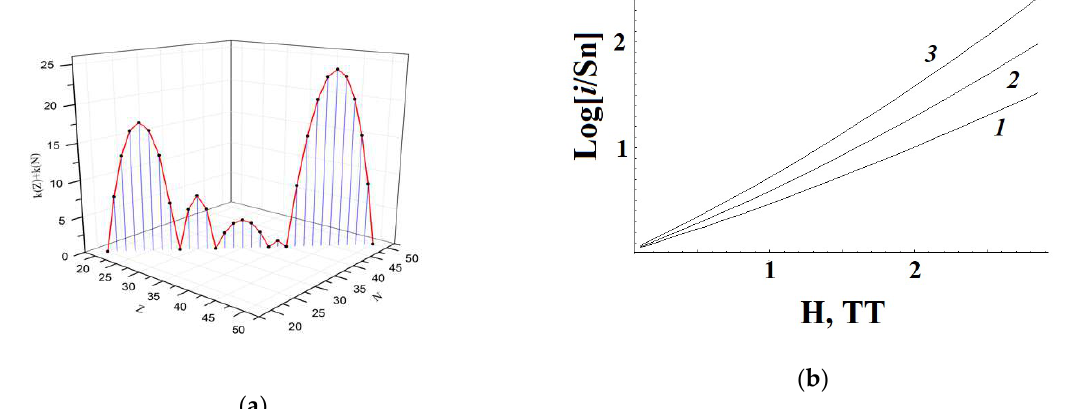
Figure 2. Nuclear magnetic effects: ( a ) Dependence on numbers of protons and neutrons of the magnetic susceptibility for symmetric nuclei in region A = 40—100; ( b ) Magnetic field dependence of the yield ratio [ i / Sn] (see text) for 100 Sn and 96 Cd—1, 92 Pd—2, 95 Rn—3 at kT = 0.5 MeV.